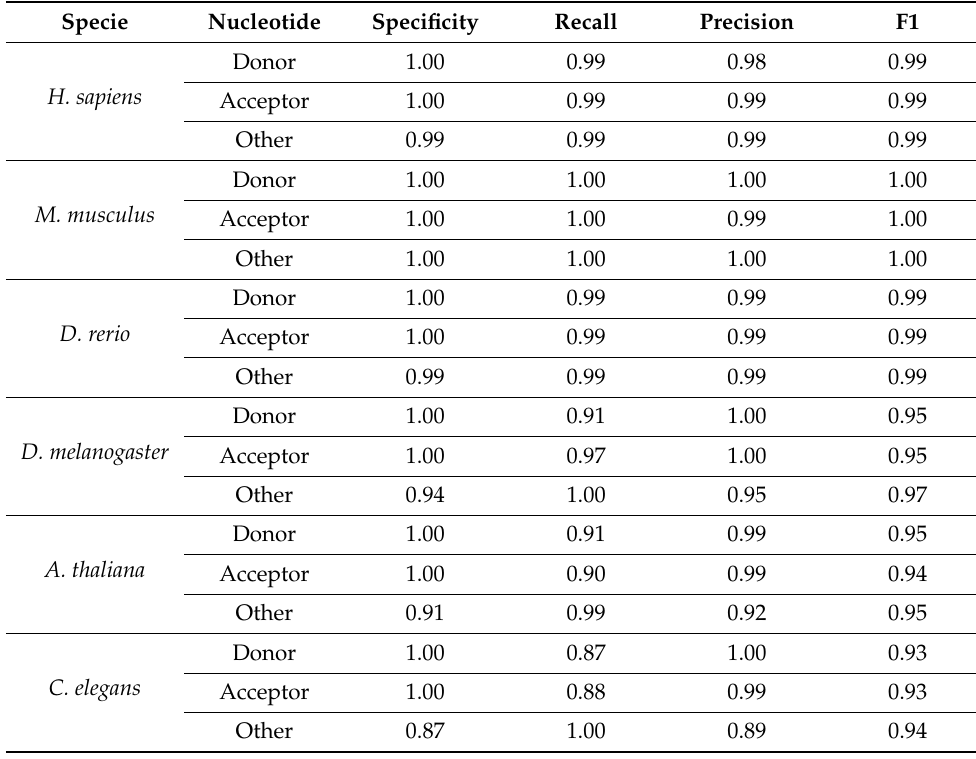
Table 5. Performance metrics of Deep Splicer evaluated on different species’ genetic